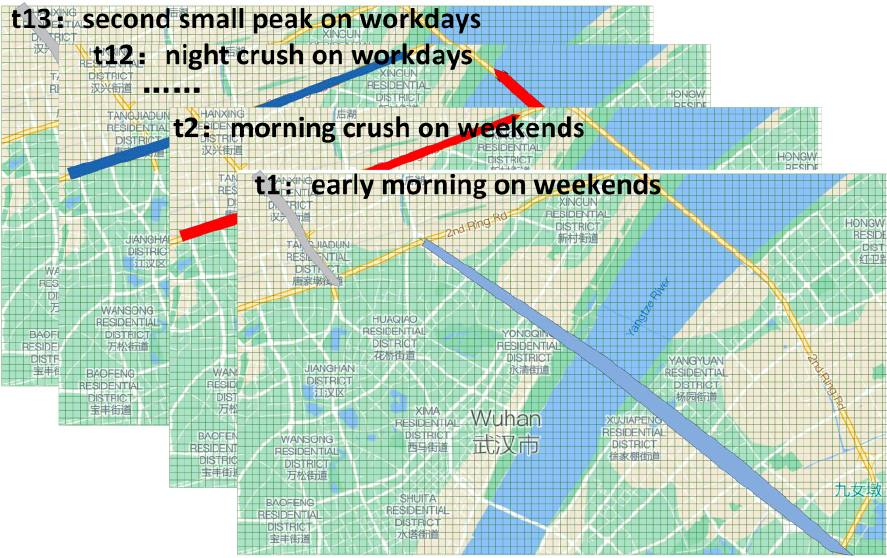
Figure 3. Multi ‐ source data fusion. Figure 3. Multi-source data